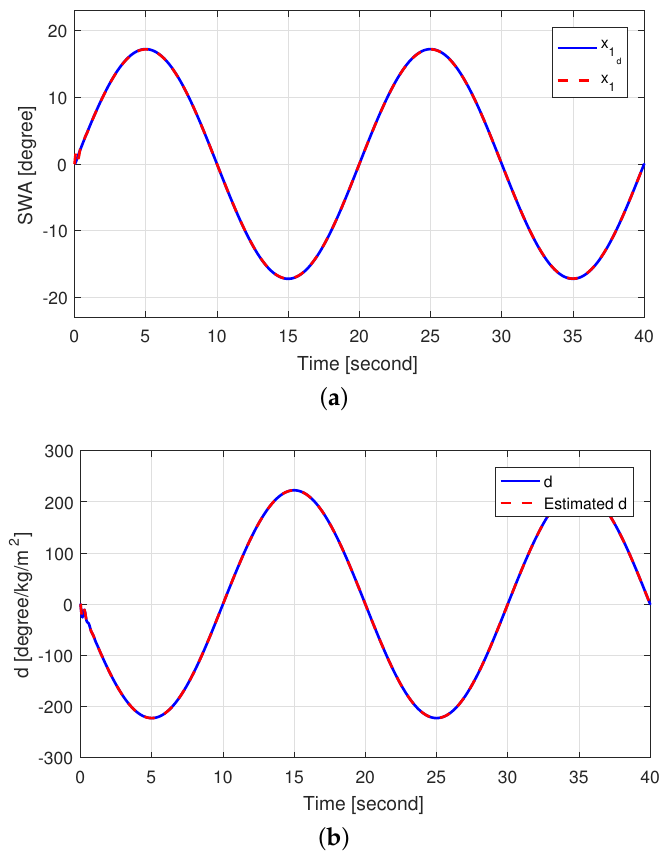
Figure 4. Simulation results ( a ) SWA tracking performance and ( b ) self-aligning torque estimation